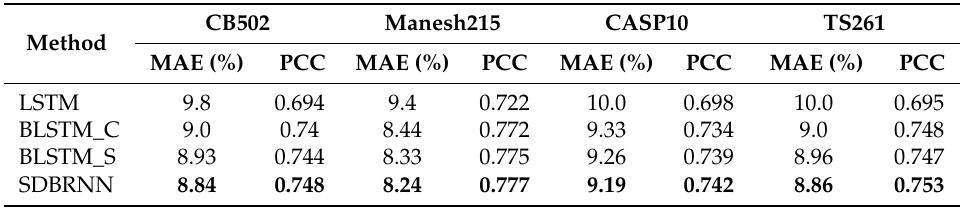
Table 7. Comparison of different LSTM models on relative RSA area prediction. MAE is the value percentage